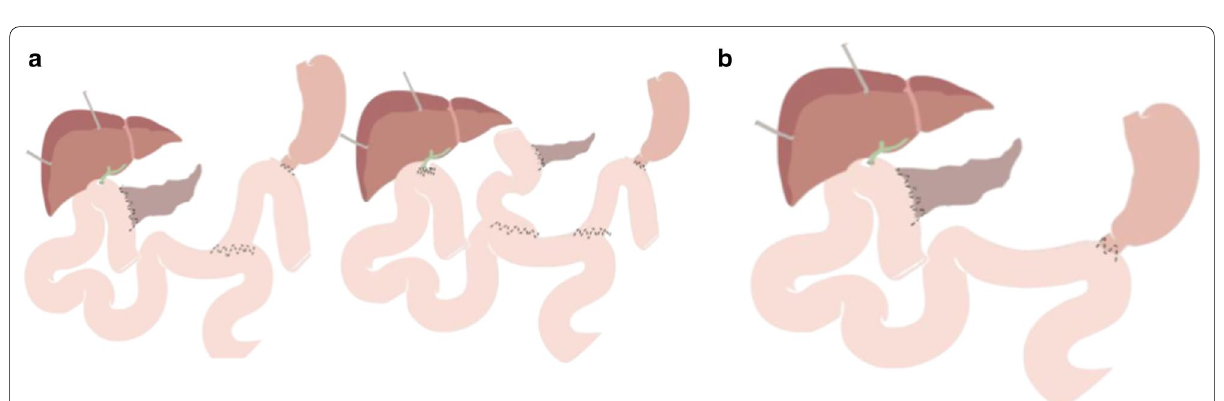
Fig. 6 Intestinal reconstruction techniques: ( a ) Y de Roux intestinal reconstruction. Left: classic type; right: Machado type. ( b ) Child type